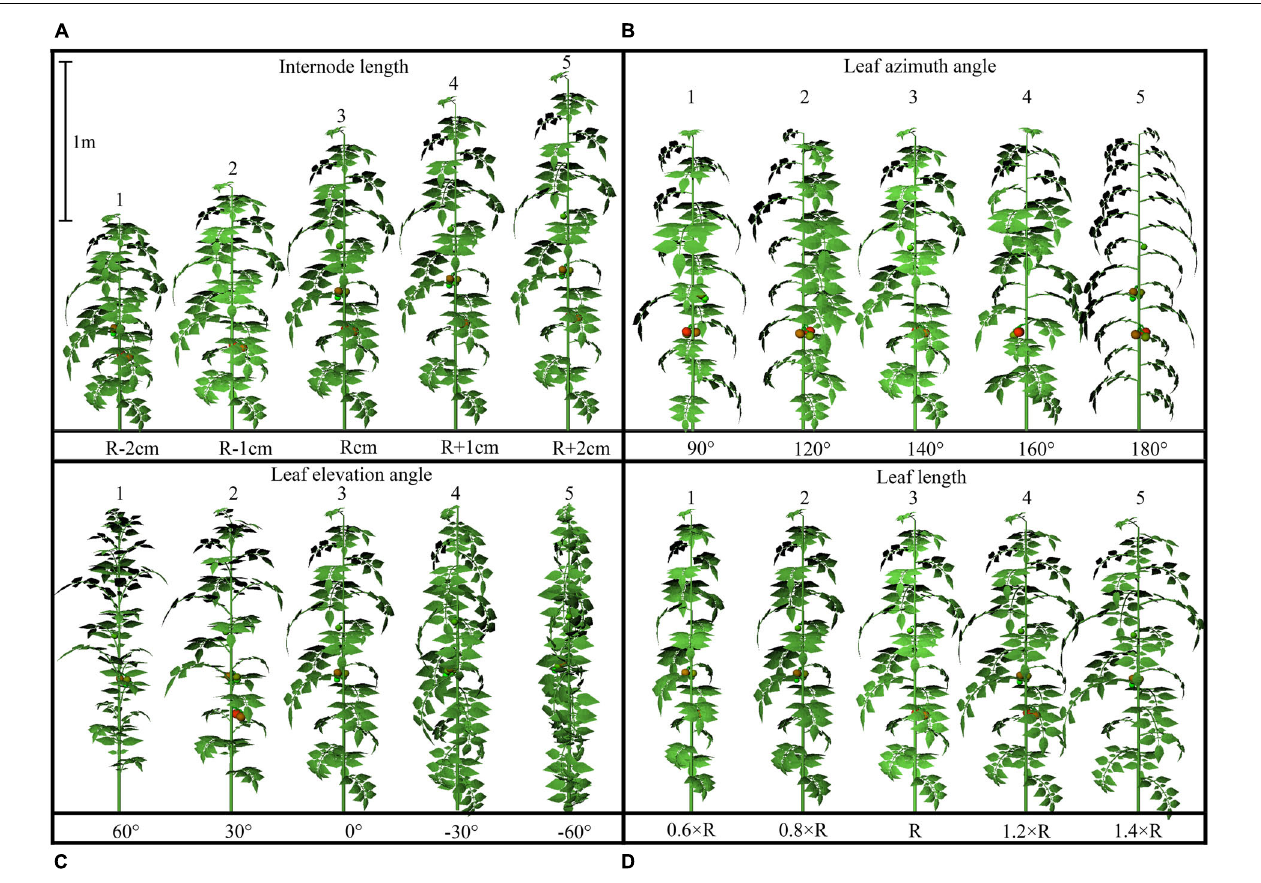
FIGURE 3 | Detailed configurations of the plant architectural traits. Each plant architecture group was simulated individually with five adaptations for each scenario. Each adaptation was applied to every leaf rank of tomato plant, with visual 3D representation of each leaf level adaptation, namely: internode length (R –2 cm, R –1 cm, R cm, R + 1 cm, R +2 cm) (A) , leaf azimuth angle (90, 120, 140, 160, 180 ◦ ) (B) , leaf elevation angle (60, 30, 0, –30, –60 ◦ ) (C) , and leaf length (0.6 × R, 0.8 × R, R, 1.2 × R, 1.6 × R) (D)